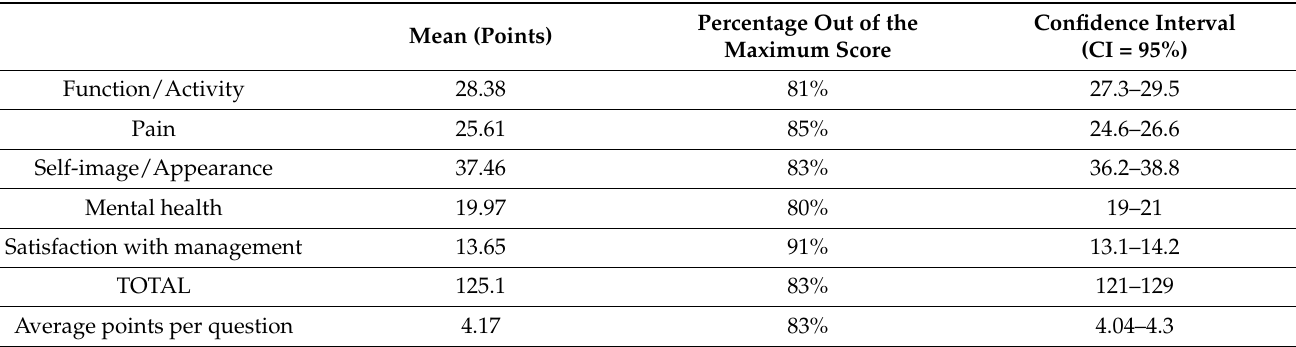
Table 2. The mean score, percentage of the maximum score, and confidence interval of SRS-30 and its domains after the surgery.